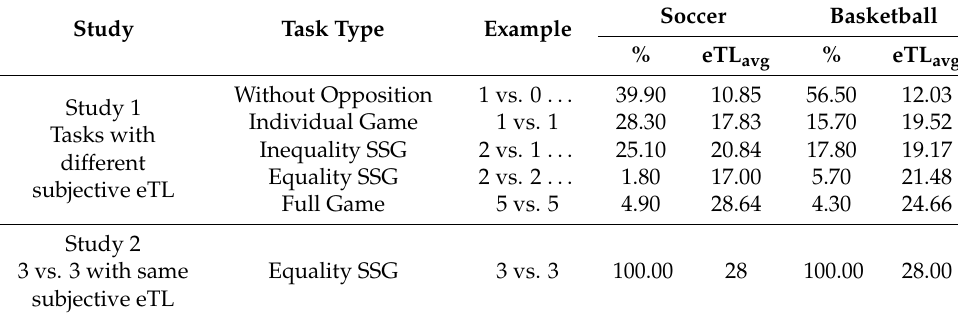
Table 1. Description of the learning tasks (by study and sport).